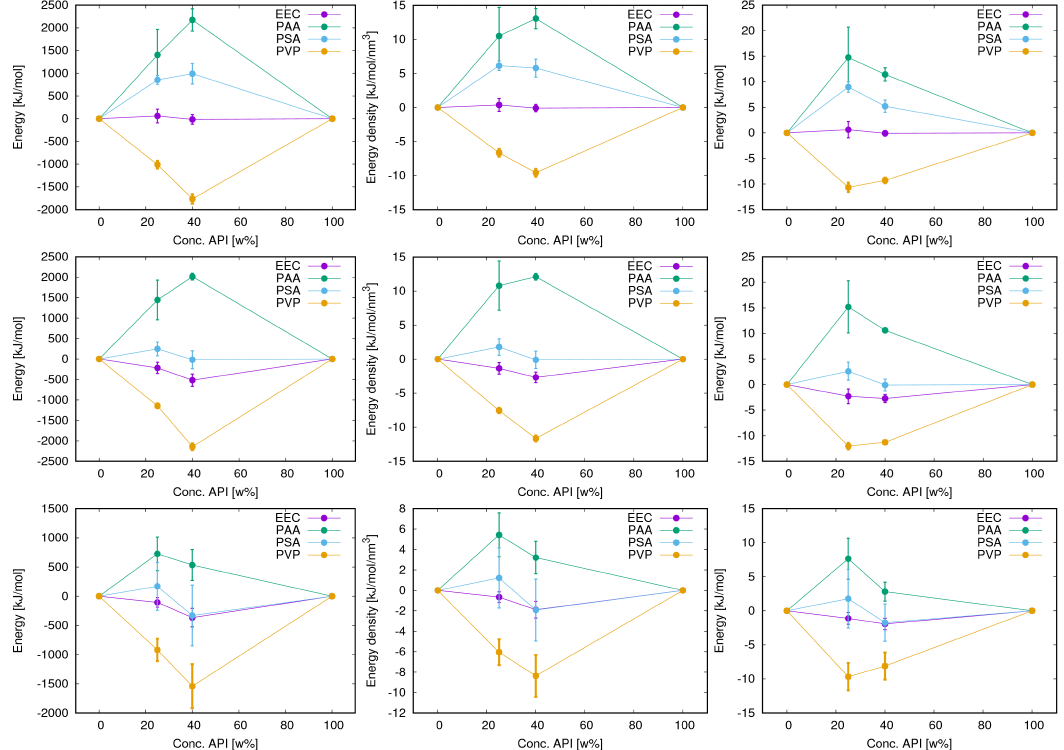
Figure 3. Variation of Energy terms with API concentration for FLA: ( left ) total energy difference; ( center ) normalized by volume; and ( right ) normalized by number of API molecules in blend. From top to bottom : E Coul , E nb , and E tot